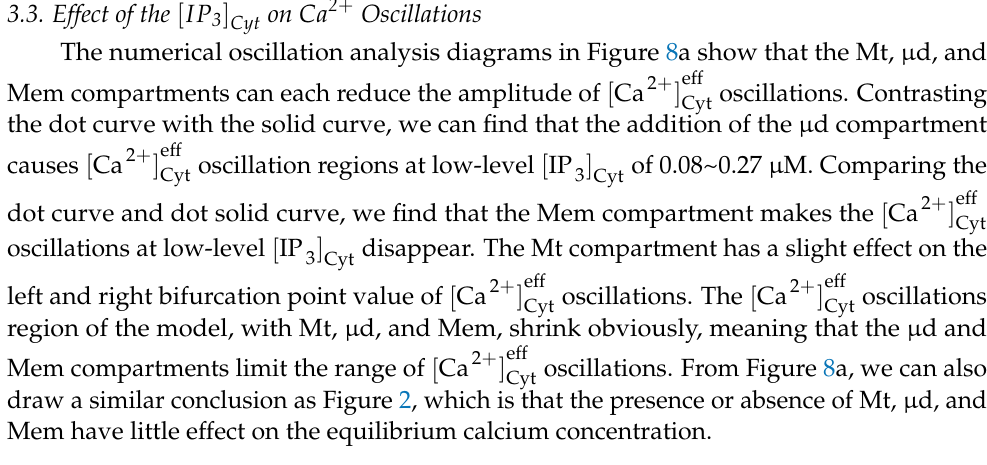
Figure 7. The period of Ca 2 + concentration of Cyt and µ d oscillations at the following different ER–Mt distances ( D ): 10, 20, 40 60, 80, 100, 120, 140, 160, 180, 200 nm. V PLC = 1 µ M s − 1 , k deg = 1.5 s − 1 , K PLC = 0.12 µ M, K deg = 0.1 µ M. The other parameters and constants are taken from Table 1. These two curves fit well, meaning that calcium oscillations of Cyt and µ d have same frequency under different ER–Mt distances.